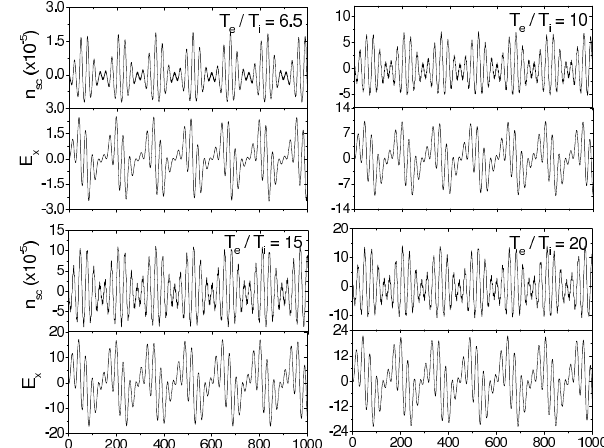
Fig. 13. Impact of the Mach number M on LH-oscilliton waves. Only space-charge density n c and electric wavefield E x -component are shown. Notice that the panels of M =1 is the typical case dis- cussed in the last section.